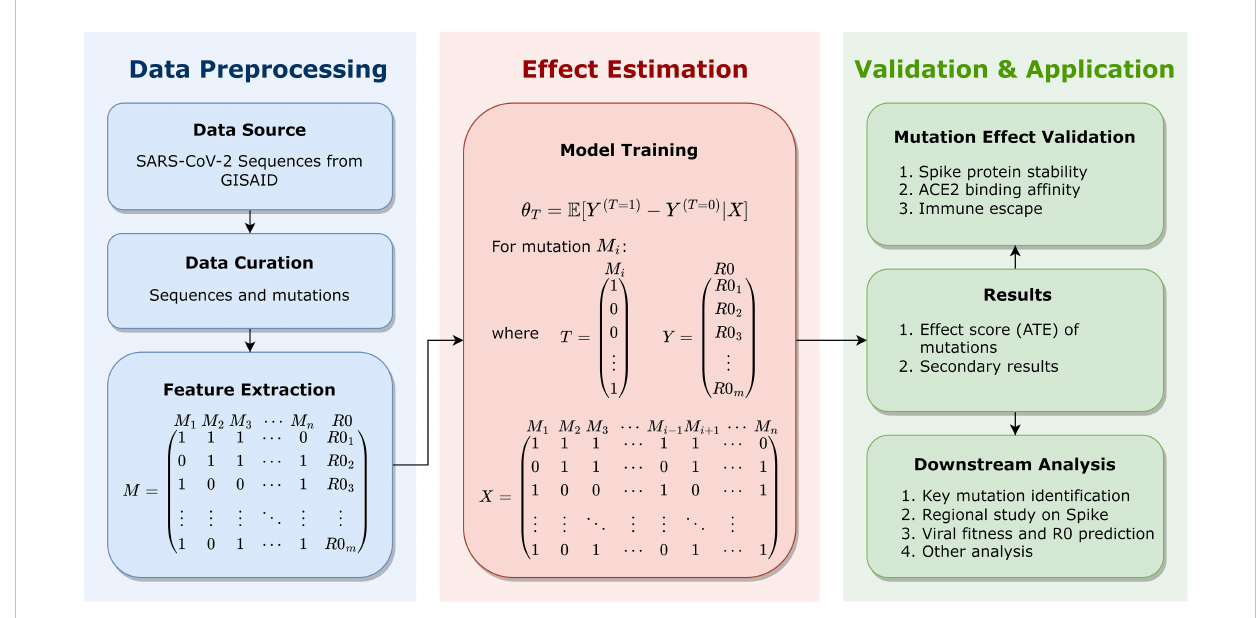
FIGURE 1 Schematic representation for the framework of this study, including the Data Preprocessing, the Effect Estimation, and the Validation and Application. Genome sequences of SARS-CoV-2 are retrieved and integrated for data curation and feature extraction, which are presented as FASTA fi les of bases (A, C, G, and T). In data curation, Spike sequences are aligned to the reference sequence for mutation detection; in feature extraction, each sequence is mapped into a mutation combination (as a boolean vector representing the existence of mutations in each sequence) with the corresponding R0, as a row vector in the feature matrix. For each mutation, the causal inference model is utilized to estimate its average treatment effect (ATE) on the outcome R0, with other mutations serving as observable covariates. Estimated ATE serves as the effect score of each mutation. Identi fi ed key mutations are validated and interpreted by computing methods for detailed mutational in fl uences, including the Spike protein stability, the human angiotensin-converting enzyme 2 (ACE2) binding af fi nity, and immune escape. Effect scores can support downstream analysis, including key mutation identi fi cation, region study of the Spike protein, viral fi tness and R0 prediction of strains,